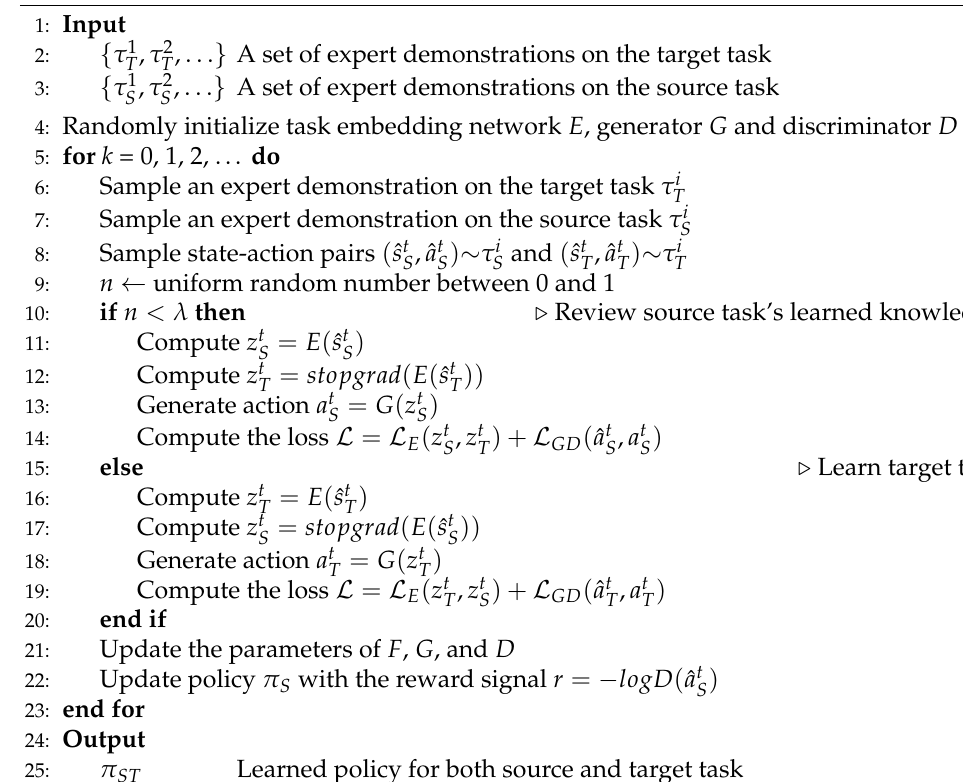
Algorithm 2 The proposed adaptation